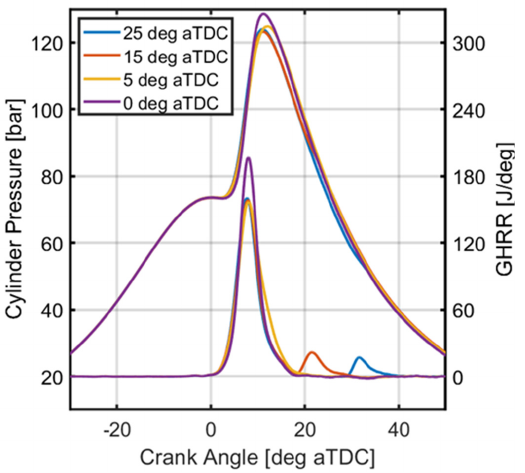
Figure 4. Cylinder pressure and gross heat release rate (GHRR) vs. crank angle for a subset of mixing-controlled injection timing sweep. The legend indicates the mixing-controlled start of injection (SOI3) timing, which contains 10% of the total injected fuel energy.